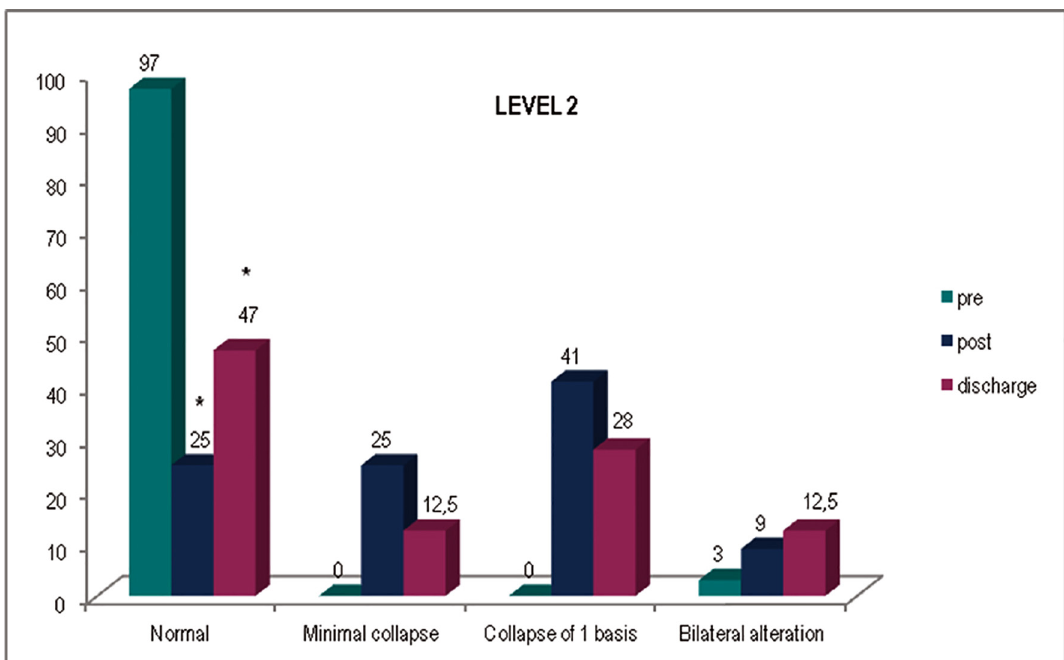
Fig. 3 - Percentage of radiological changes of level 2 in the pre, post and discharge of